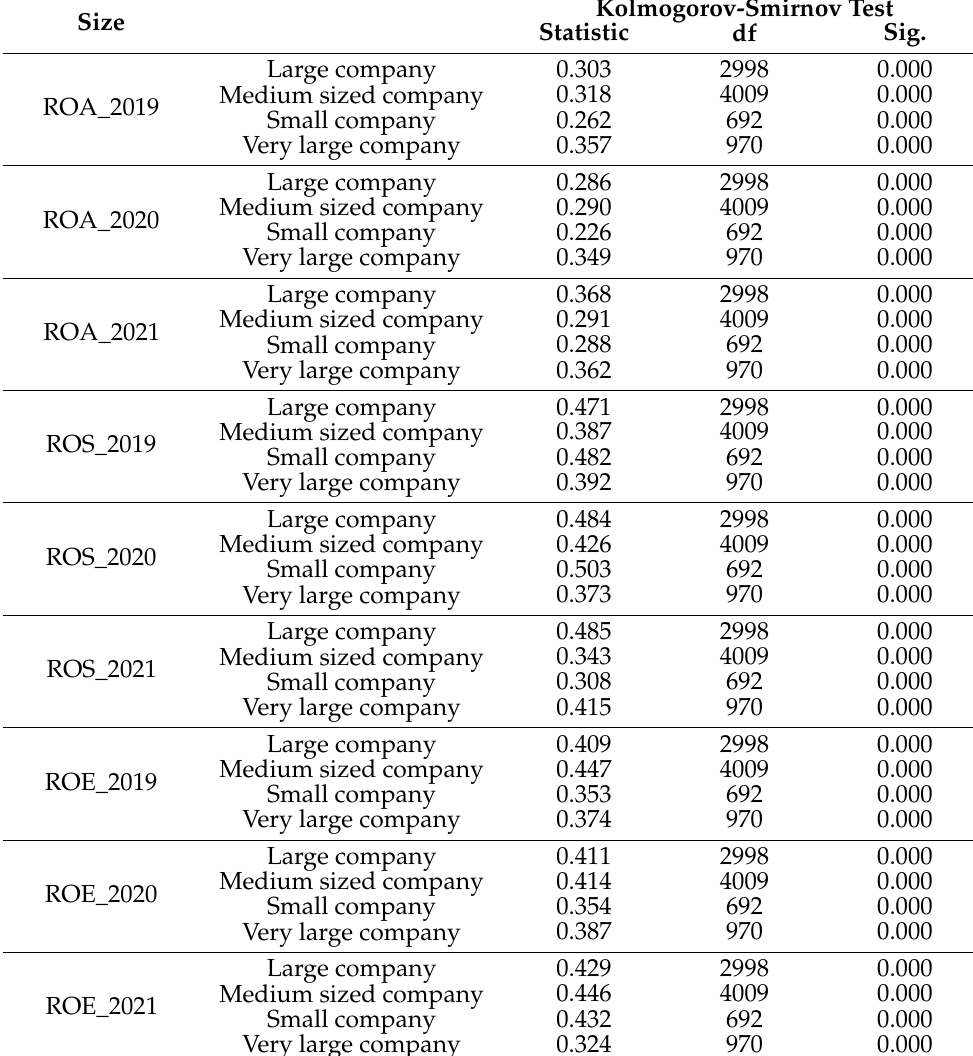
Table 6. Normality test. Source: own